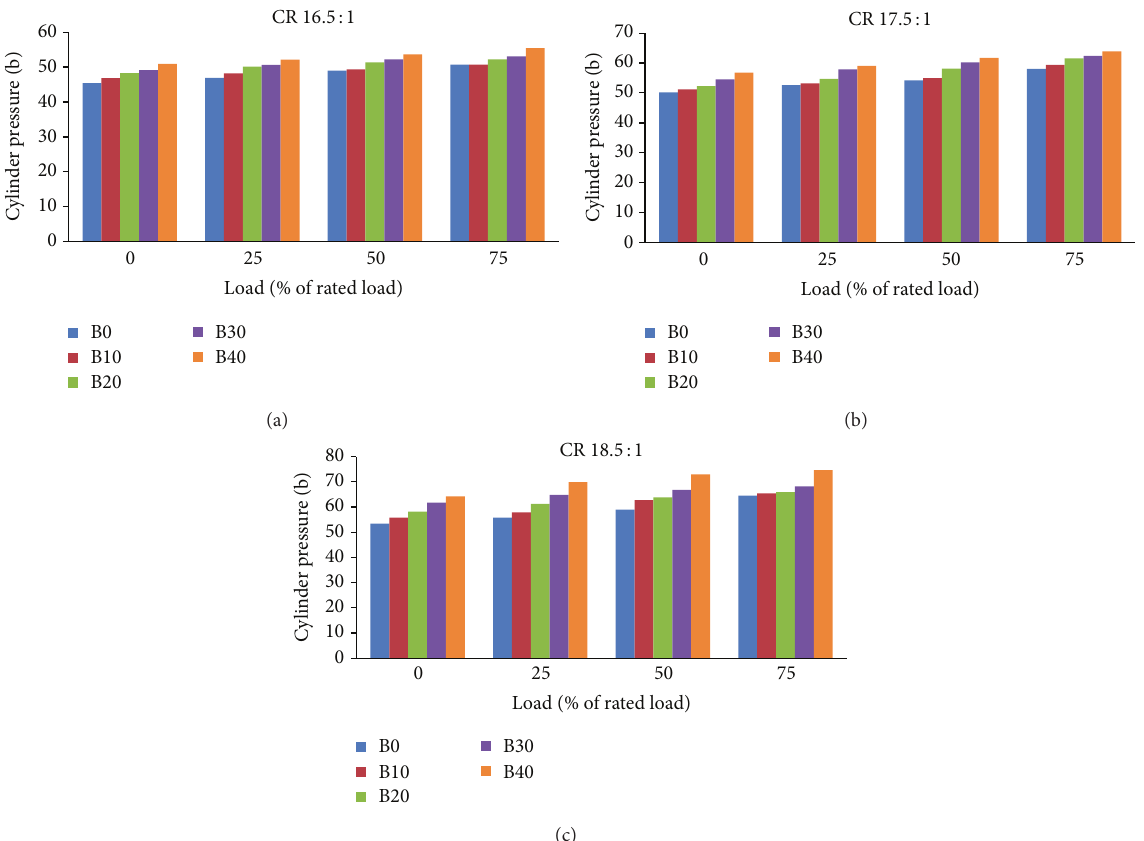
Figure 3: Variation of peak cylinder pressure with engine load for all fuel at compression ratios of 16.5, 17.5, and 18.5, respectively.